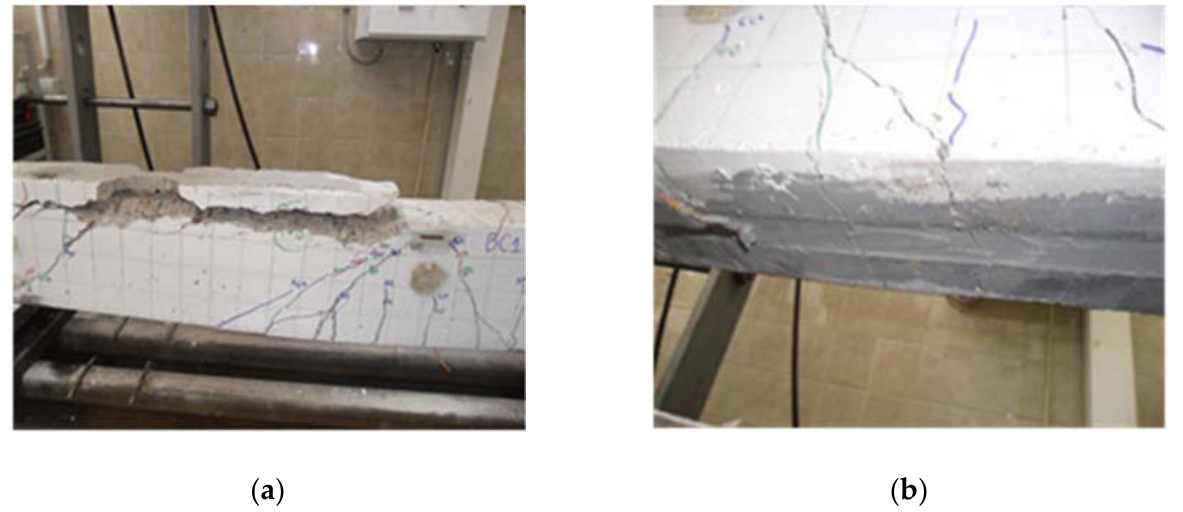
Figure 20. Beam B-C: ( a ) Concrete separation at the level of protective layer of concrete ( b ) Arrangement of cracks.